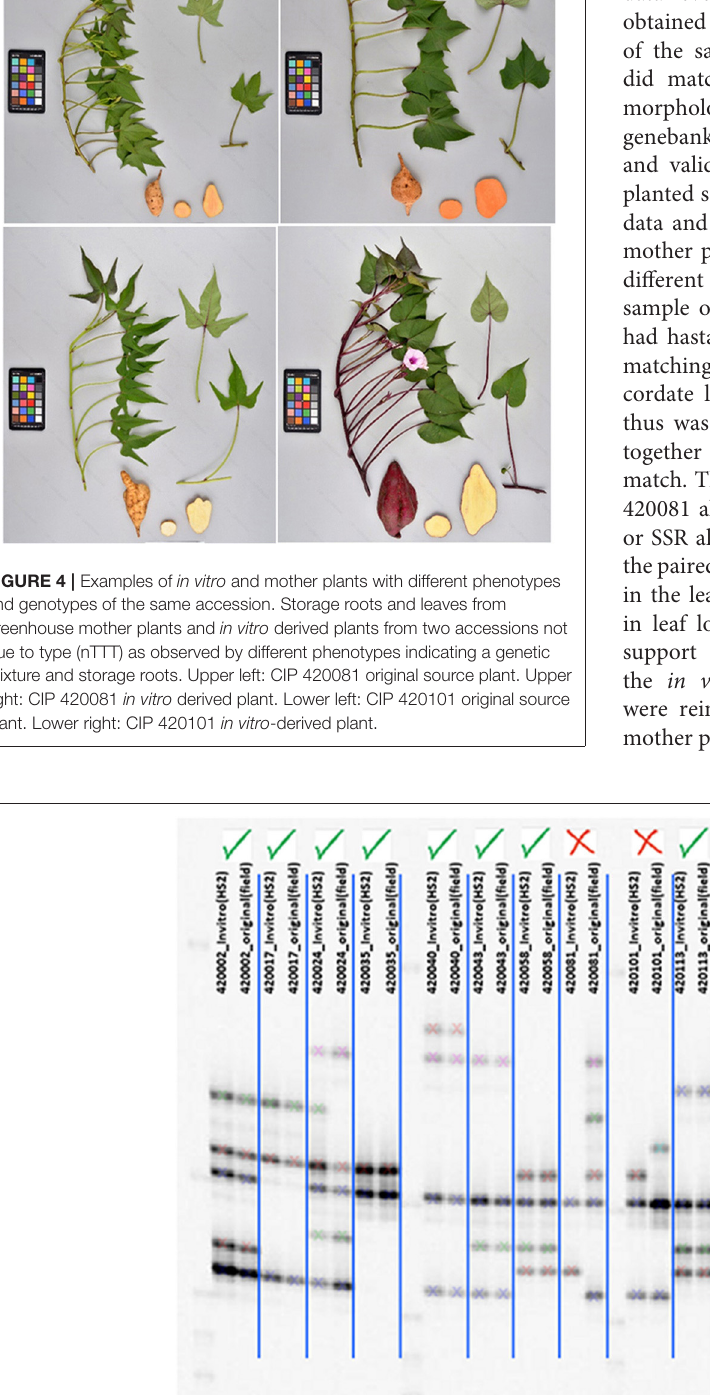
Frontiers in Plant Science |